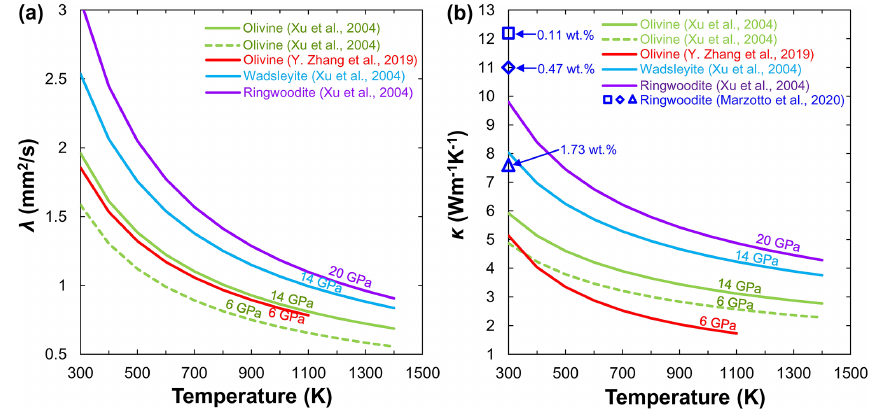
Figure 9. (a) Thermal diffusivity and (b) thermal conductivity of olivine, wadsleyite, and ringwoodite versus temperature (Xu et al., 2004; Y. Zhang et al., 2019; Marzotto et al., 2020).